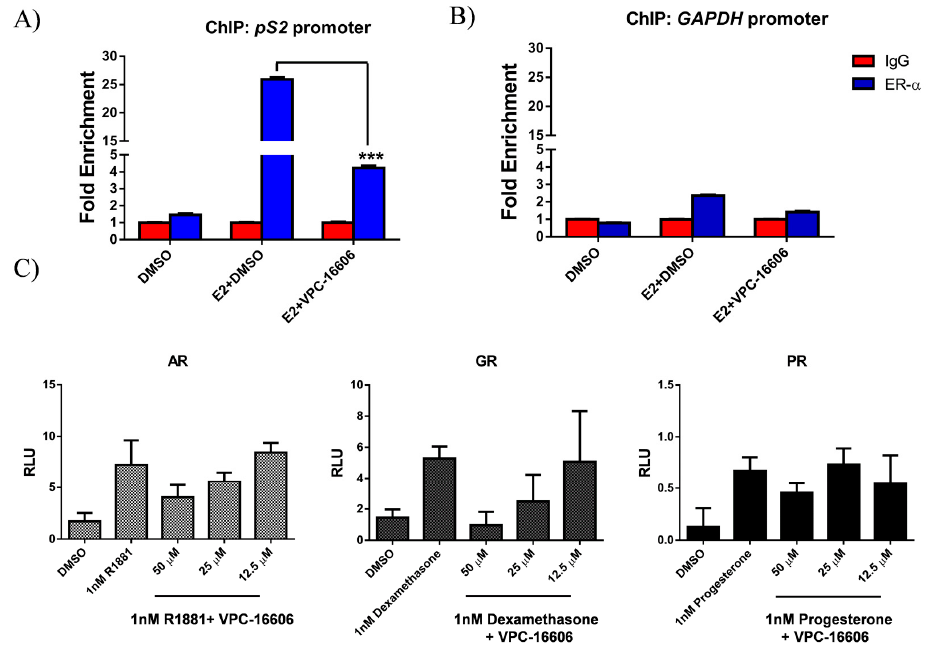
Figure 4. Further activity profile of VPC-16606. ( A , B ) Chromatin immunoprecipitation (ChIP) analysis of ER α binding to the pS2 enhancer, or the GAPDH promoter, in MCF7 cells. Where indicated, ER α was stimulated with 1 nM E2 or dimethyl sulfoxide (DMSO) alone, and the compound was administered at a 6 µ M concentration. Sheared chromatin-protein complexes were precipitated with the ER α antibody, reverse cross-linked and analyzed by quantitative PCR. The results are normalized as fold enrichment over precipitation with a rabbit isotype control IgG antibody for each condition tested. Error bars indicate standard error of the mean (SEM) for 3 independent experiments performed in triplicates. Fold enrichment from the compound tested condition (ER α antibody) was statistically compared against DMSO + E2 with a two-tailed t -test (unpaired) *** indicates p -value <0.001. ( C ) Specificity of VPC-16606 was evaluated in the luciferase reporter assay. PC3 cells were transfected with plasmids expressing androgen receptor (AR), progesterone receptor (PR) or glucocorticoid receptor (GR) along with their responsive luciferase reporter constructs bearing androgen response element (ARE), progesterone response element (PRE) or glucocorticoid response element (GRE), respectively. The cells were treated for 24 h followed by lysis and measurement of luciferase signal. Y-axis represents relative luminescence (RLU) after normalizing to constitutive renilla